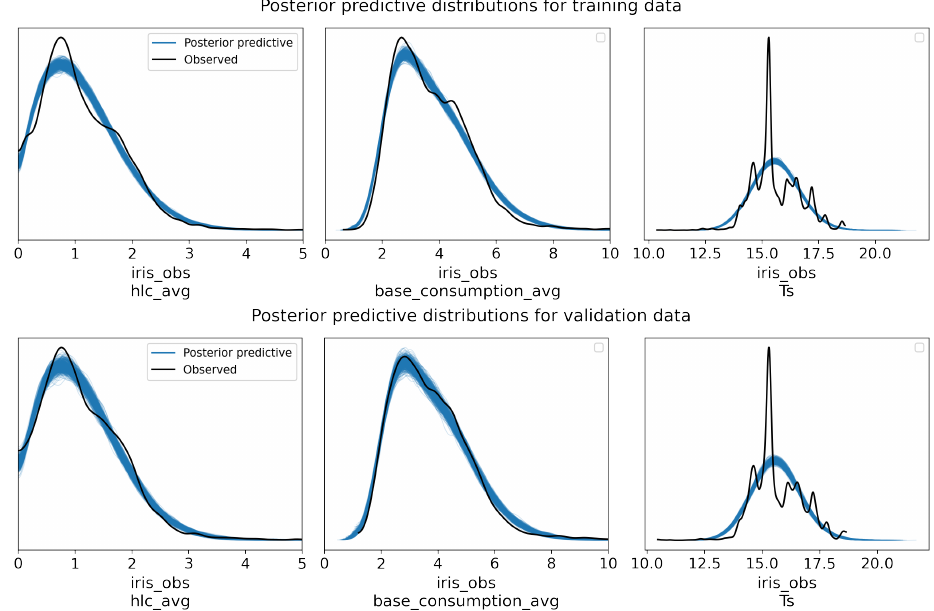
Figure 14. Posterior predictive distributions for training and validation data—types and dates